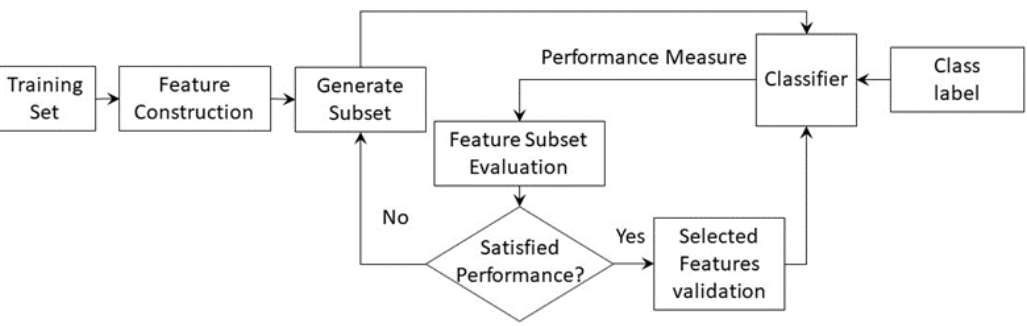
Figure 7. Wrapper technique framework used for feature selection.